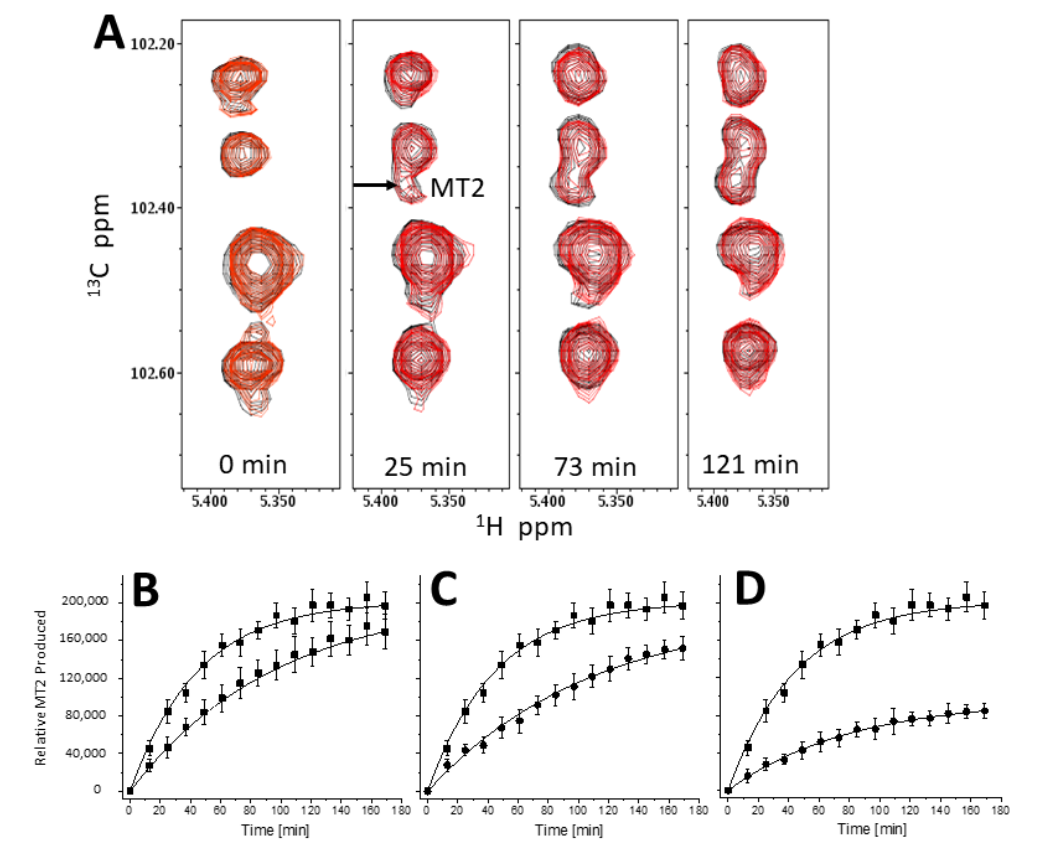
Figure 7. Natural abundance of 13 C HSQC showing the time dependence of α -amylase-mediated (0.4 U/mL) hydrolysis of MT6 ( A ). Kinetics runs focused on resonances from acetal/anomeric groups. Resonance assignments for maltose (MT2), maltotriose (MT3), and maltohexaose (MT6) were reported by Goffin et al. [27], and confirmed here by running and analyzing 1 H- 13 C HSQC and 1 H- 13 C HMBC experiments. 13 C HSQC spectra are shown in the absence (black contours) and presence (red contours) of PLG-007 (4.2 mg/mL). Time points are indicated on the figure. Using the full set of 13 C HSQC spectra, peak volume integrals were determined for the best resolved resonance; i.e., MT2 as labeled, and plotted for production of MT2 at PLG-007 concentrations of 1.1 mg/mL ( B ), 2.1 mg/mL. ( C ), and 4.2 mg/mL ( D ). Data are shown for kinetic runs performed in the absence (filled squares) and presence of PLG-007 (open circles). Solution conditions are 20 mM potassium phosphate, pH 7, 30 °C.